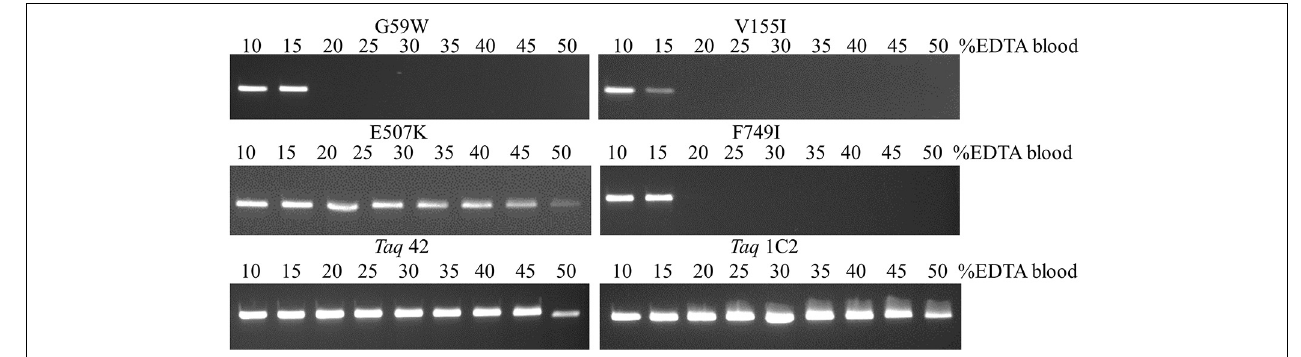
FIGURE 5 | Amplification directly from blood. A 322bp IGF target was amplified from 5 to 25 μ l EDTA-blood using 50ng of each mutant Taq DNA polymerase. Reactions were cycled on the SureCycler 8800 using the following parameters: 5min at 90 ◦ C, followed by 30 cycles of 30s at 95 ◦ C,